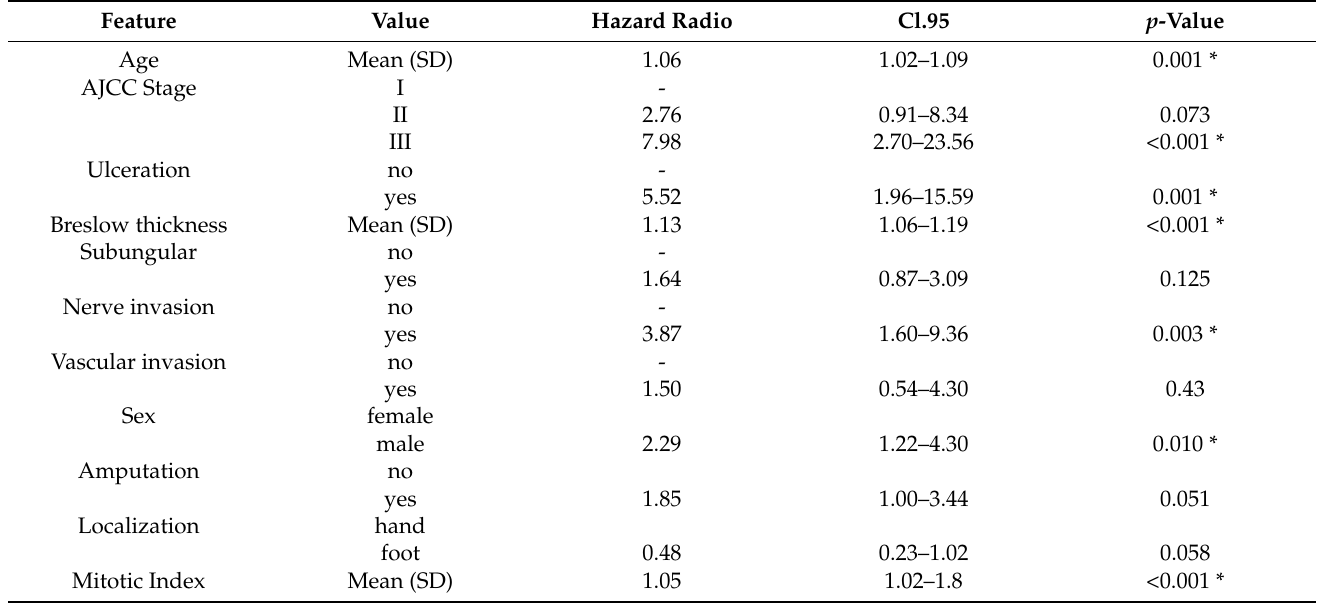
Table 5. Univariate analysis of clinical and histopathological features. Statistical significance ( p ≤ 0.05) marked with